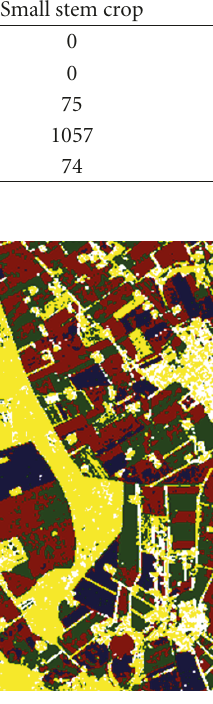
Figure 5: Classification of EMISAR image based on MCSM and